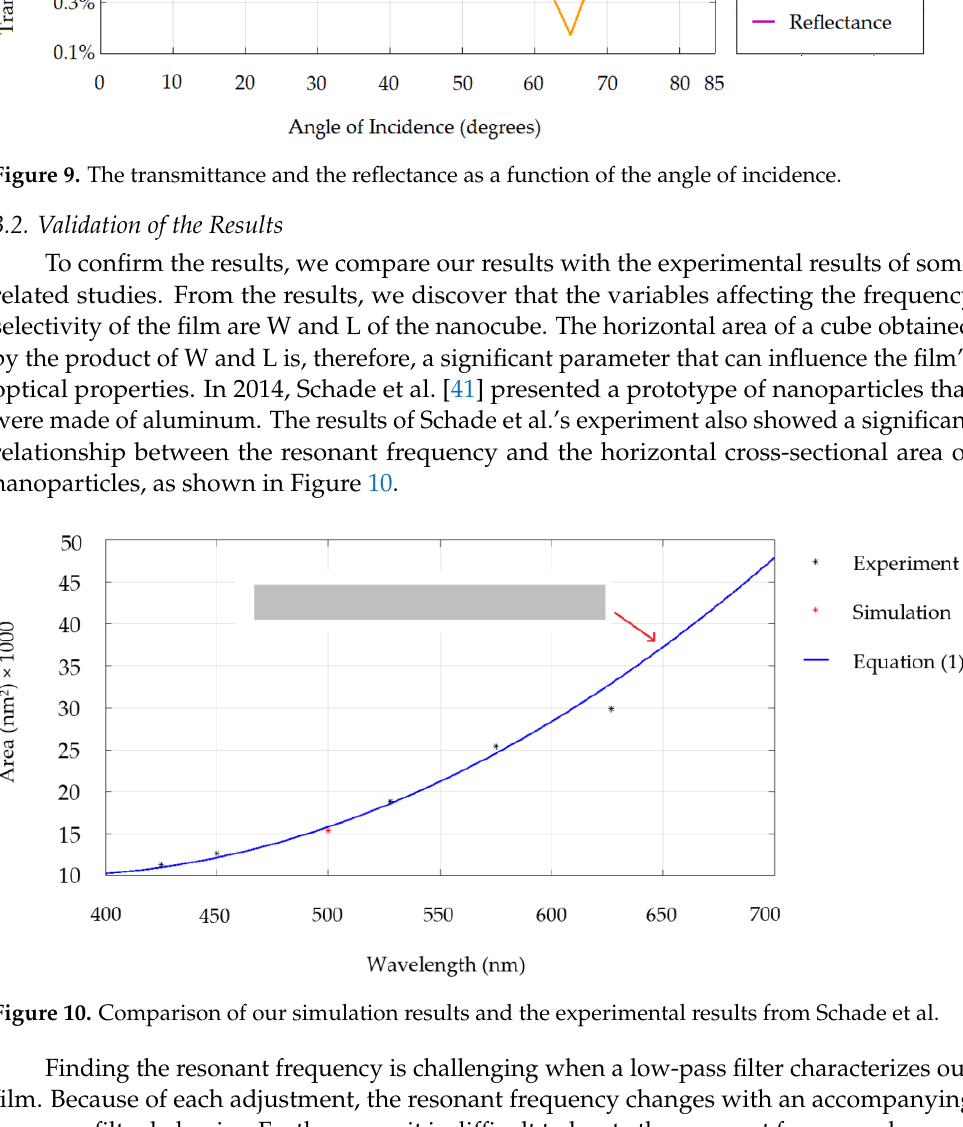
Figure 9. The transmittance and the reflectance as a function of the angle of incidence.